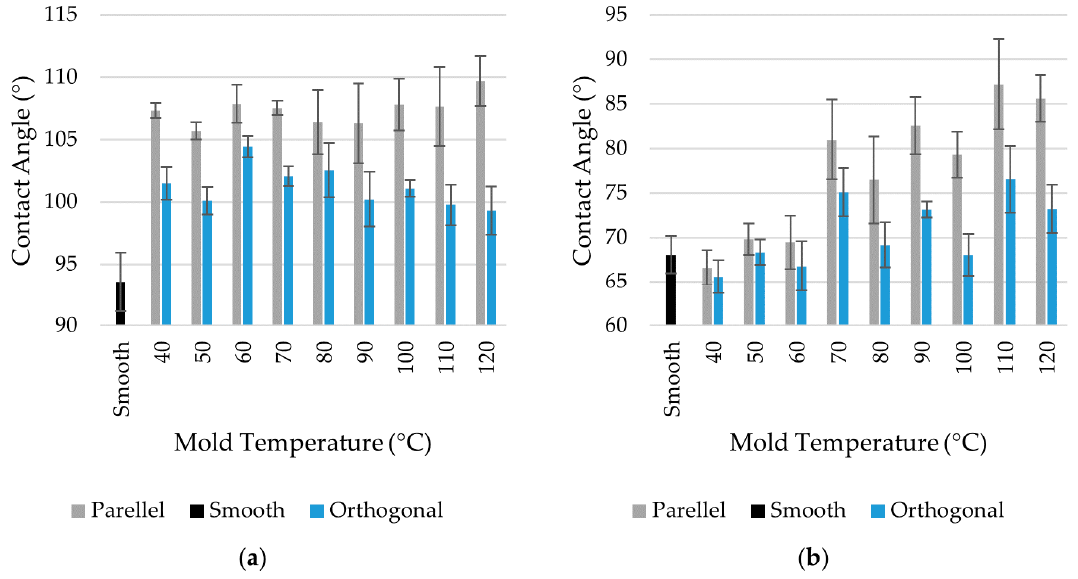
Figure 9. Results of contact angle measurements for (a) PS and (b) PMMA plastic parts.